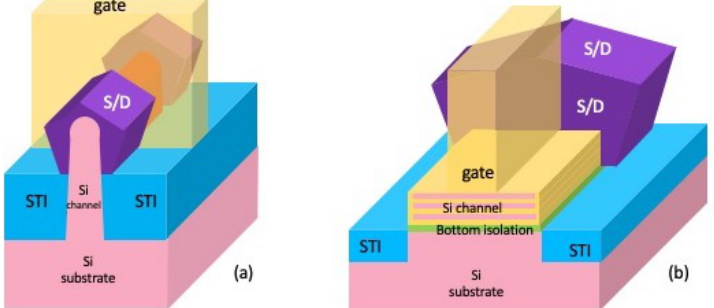
Figure 1. This figure shows a FinFET and a GAA nanosheet FET side-by-side. ( a ) A FinFET with shallow trench isolation (STI), source/drain (S/D) epitaxy, and a high-k metal trigate is depicted schematically. ( b ) A GAA nanosheet FET with STI, S/D epitaxy, bottom dielectric isolation (BDI), and high-k all-around metal is pictured. Some features, such as BDI and isolation between gate and S/D, are unique to the GAA nanosheet